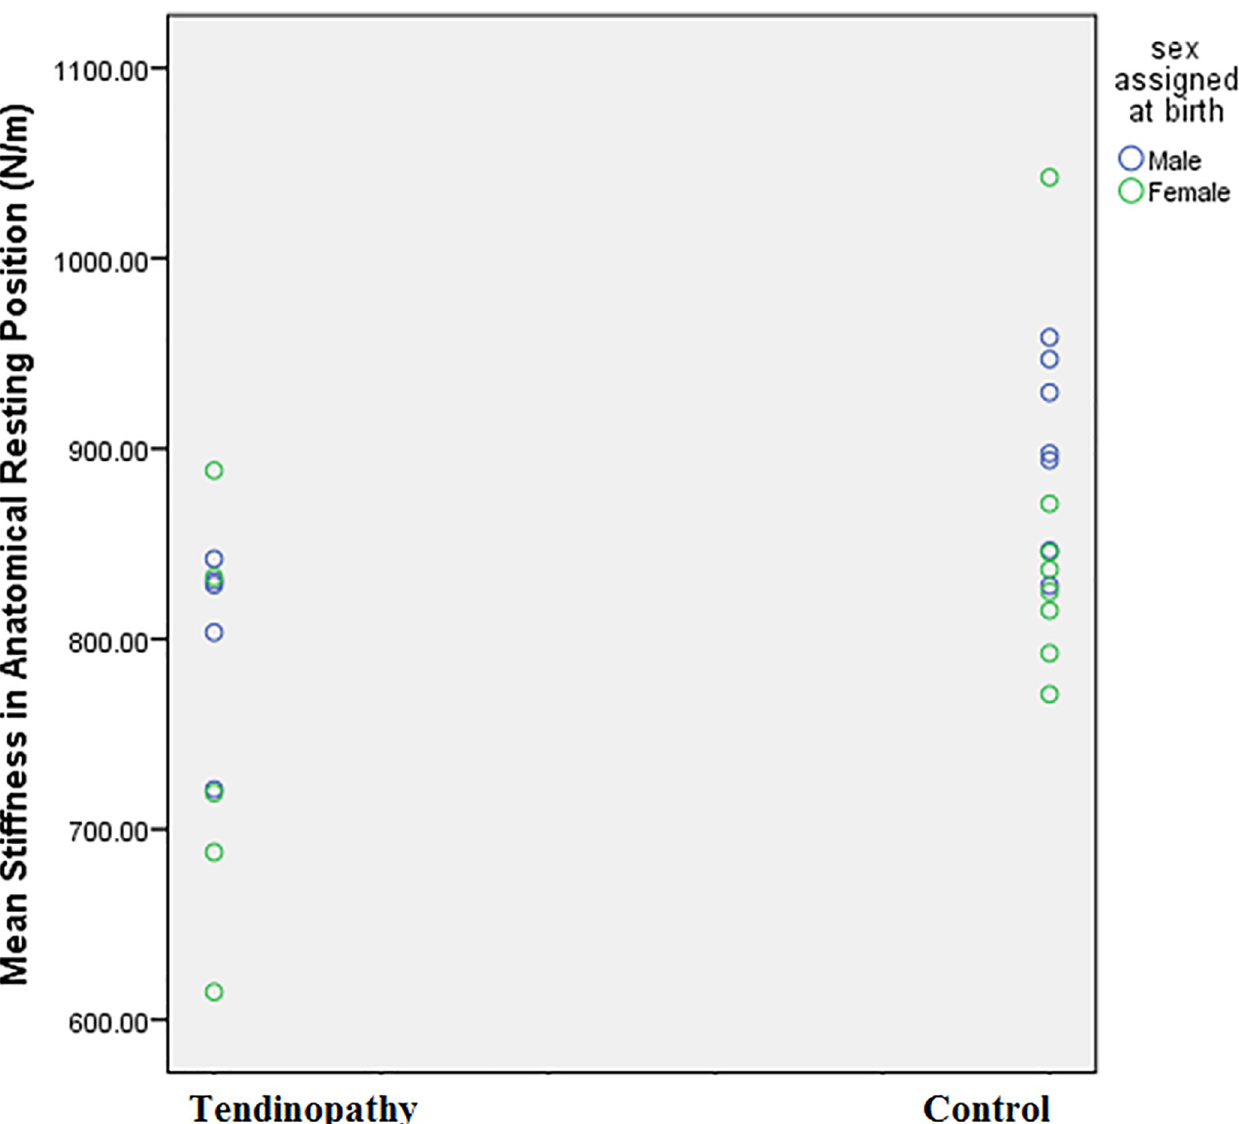
Fig 2. Achilles tendon transverse stiffness ( k ) in recreational runners with or without tendinopathy. Average stiffness was lower among patients with TR Achilles tendinopathy (777 N/m (86)) than controls (873 N/m (72), p < 0.05, n = 25). Black circles denote males, blue denote females.